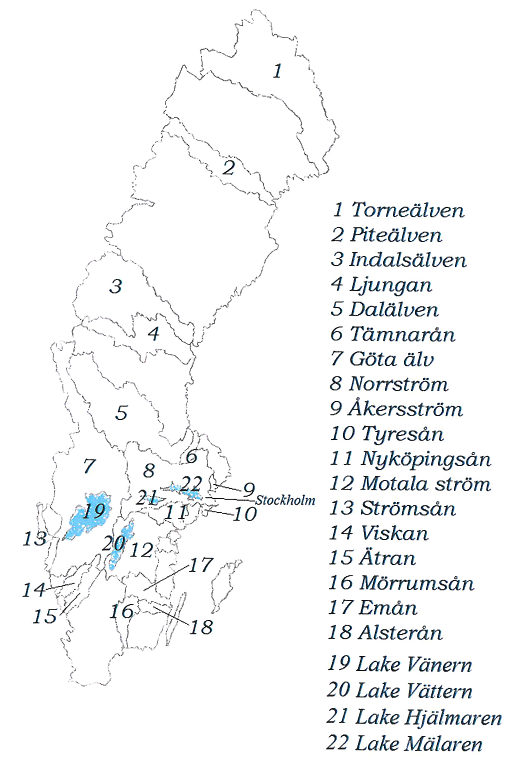
Figure 1. Catchment areas and major lakes in Sweden mentioned in the